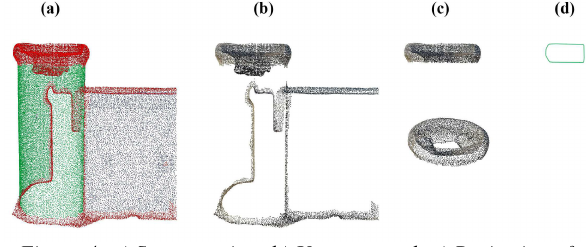
Figure 4: a) Segmentation; b) Unsegmented; c) Projection of the extracted revolution points; d) Polygonal profile.